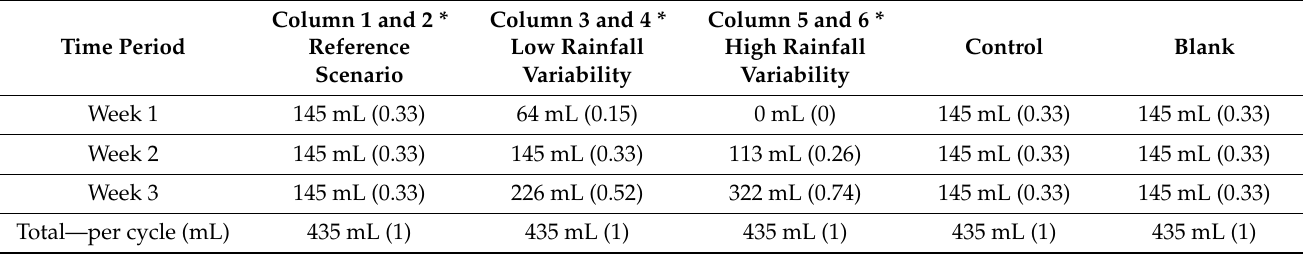
Table 3. Distilled water added to each set of columns as precipitation, and associated ratios between weekly and total (cyclic) volumes of added water (in